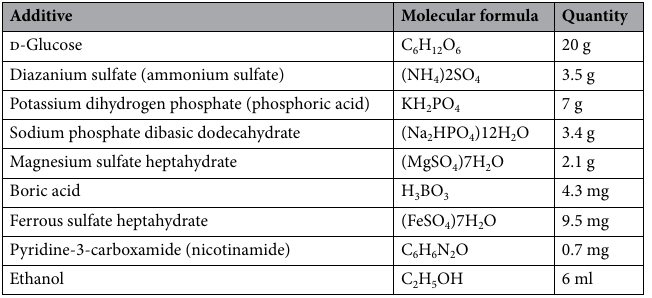
Table 1. Composition of culture medium for Acetobacter xylinum . Additives for 1 l of medium in Milli-Q filtered